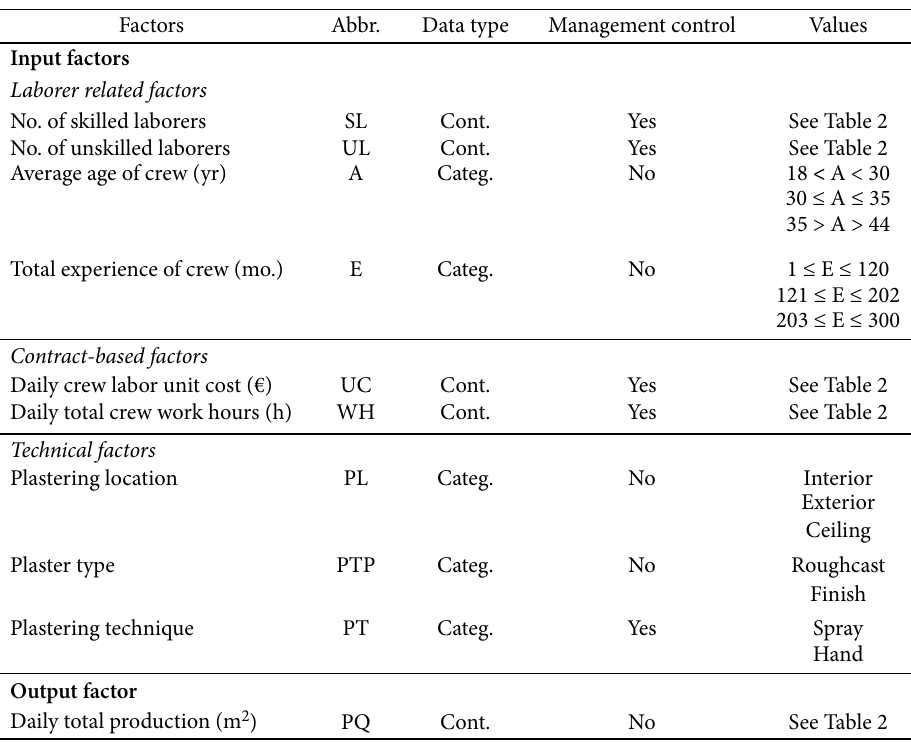
Table 1. Crew efficiency input factors included in the study